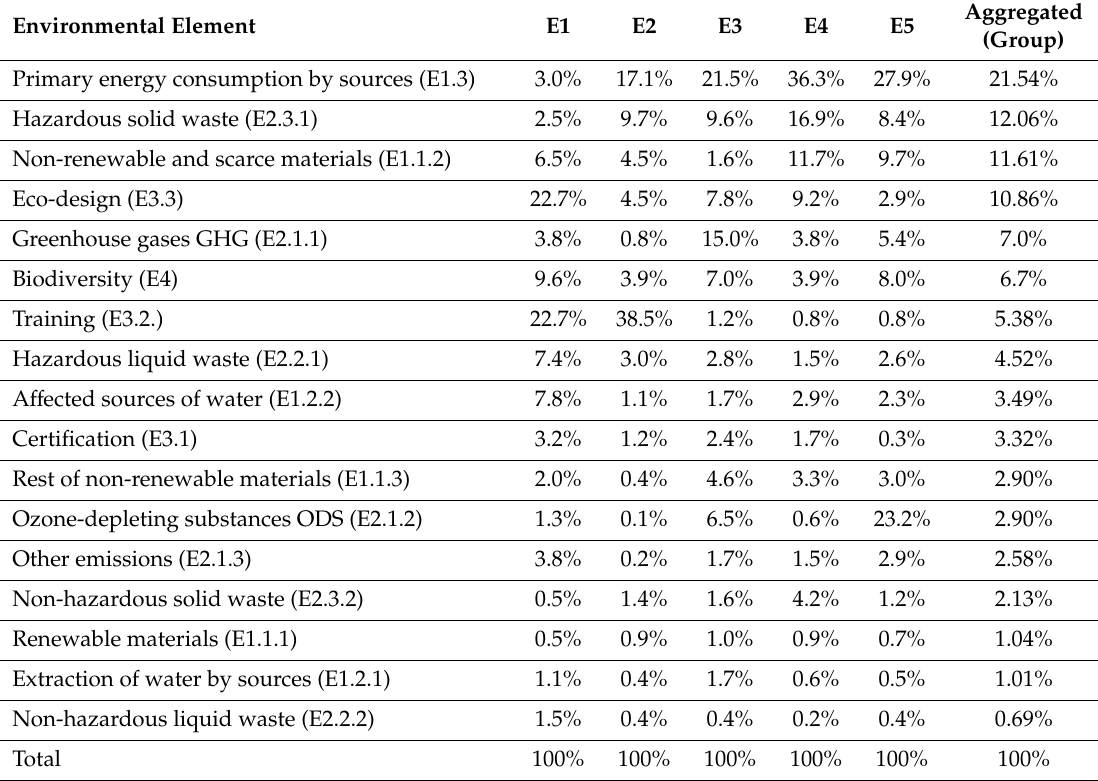
Table 3. Prioritized list of environmental elements for anticipation and reflexivity activities for ICT for AHA projects. Individual weights assigned by each expert (E) in percentage, and aggregated weight for the